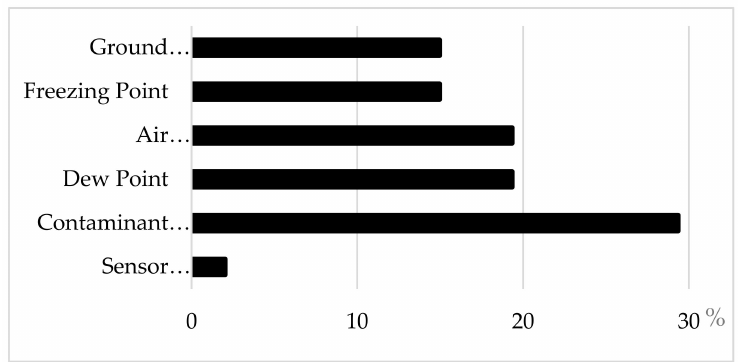
Figure A3. Contribution of weather parameters (in %) to the model developed by A é roports de Paris within SESAR validation using data from Poprad–Tatry